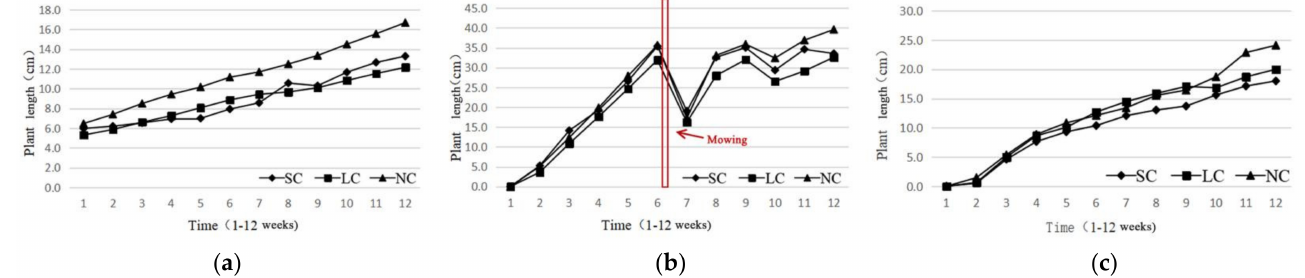
Figure 4. ( a ) Graph of C. dactylon height growth over 12 weeks. ( b ) Graph of A. stolonifera height growth over 12 weeks. ( c ) Graph of S. argenteostriatus height growth over 12